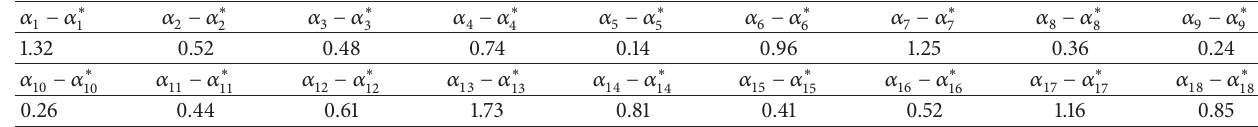
Table 6: Weights of support vectors of SVM2.